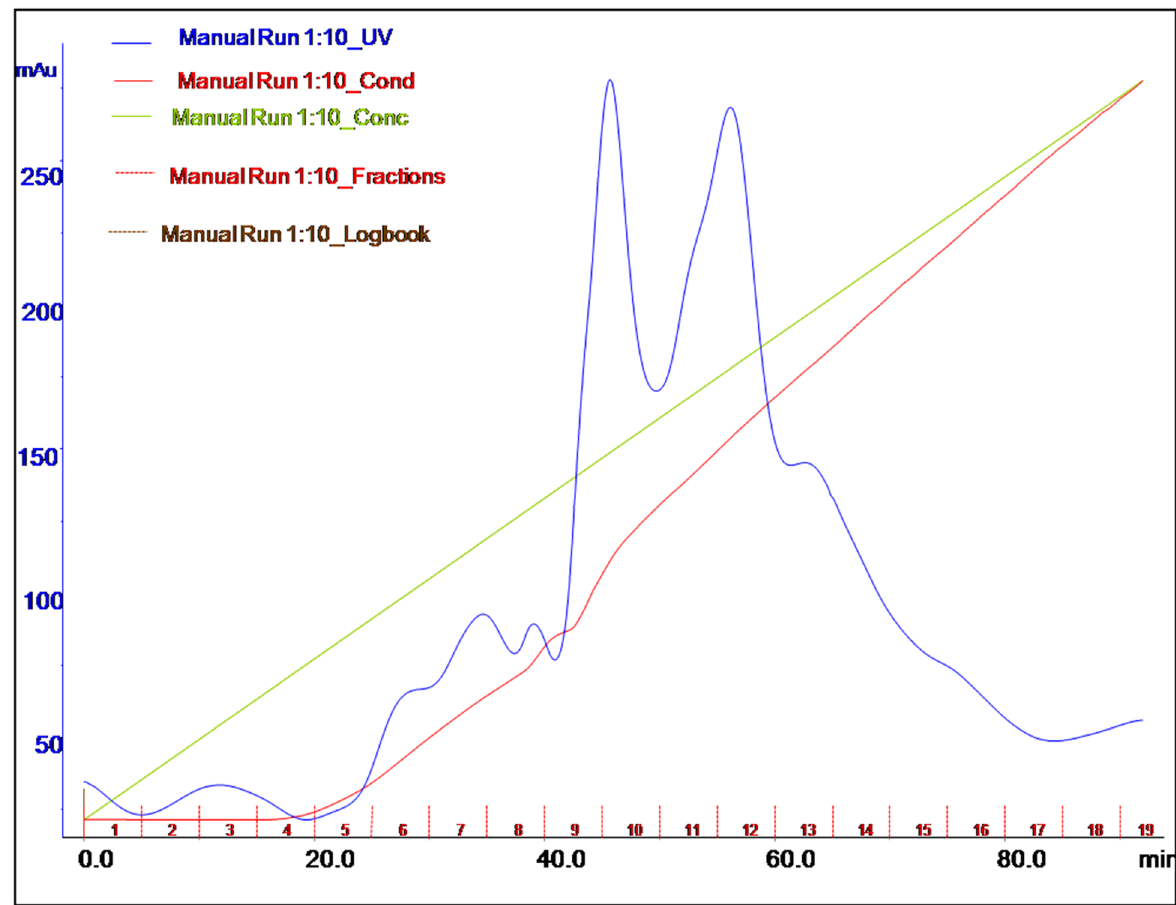
Figure 3. Elution profile of the protease/keratinase enzyme after loading on a Q FF strong anion exchange column.